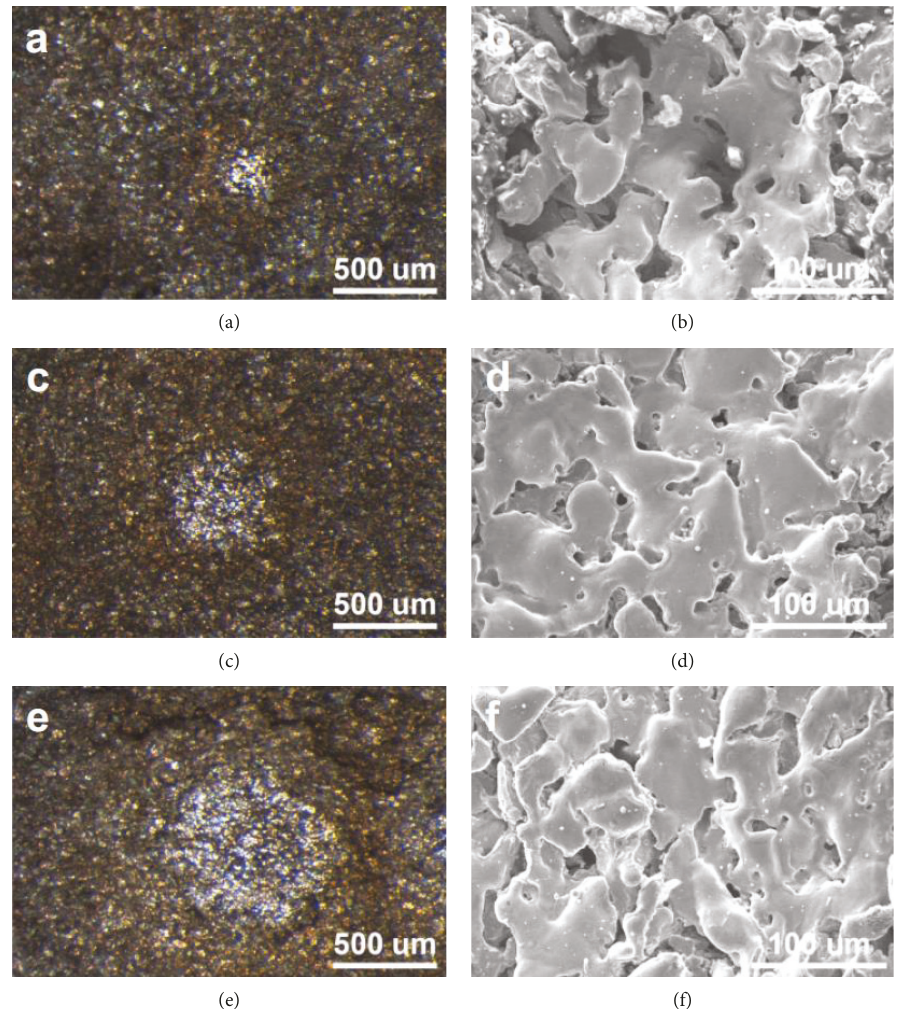
Figure 6: Ablation craters from 20 consecutive laser pulses using 50 mJ (a), (b); 100 mJ (c), (d); and 200mJ (e), (f). (a), (c), and (e) are taken with a SEM (Copyright 2016 Trans Tech Publications Ltd. reprinted with permission